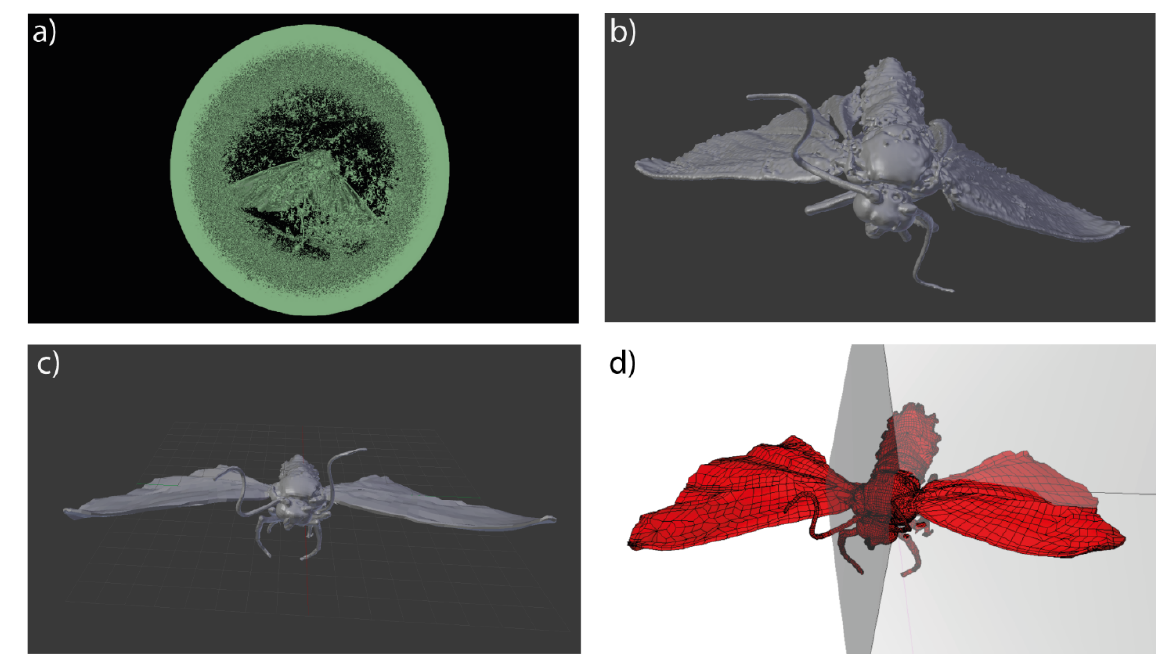
Figure 1. Illustration of the steps taken to convert the micro-CT scan data into the mesh used by WiPL-D: ( a ) depicts the micro-CT data within Slicer 3D, with limited thresholding applied; ( b ) depicts the final stereolithography data exported from Slicer 3D and used in Blender to create a 3D mesh of the specimen’s surface; ( c ) shows the final 100% resolution 3D model of the specimen created in Blender; ( d ) depicts the mesh of the 3D model created in WiPL-D using only 25.0% of the number of plates of the 100% resolution model.